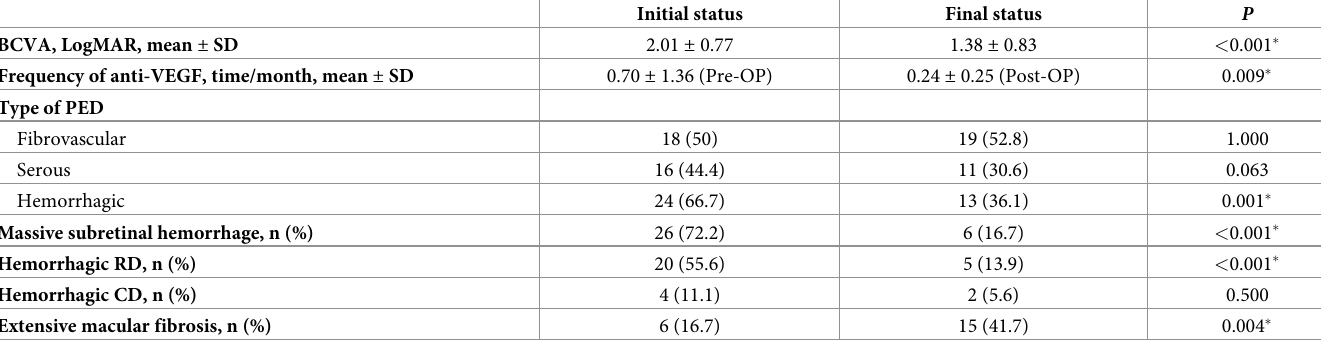
Table 2. Comparison of patients with breakthrough vitreous hemorrhage before and after